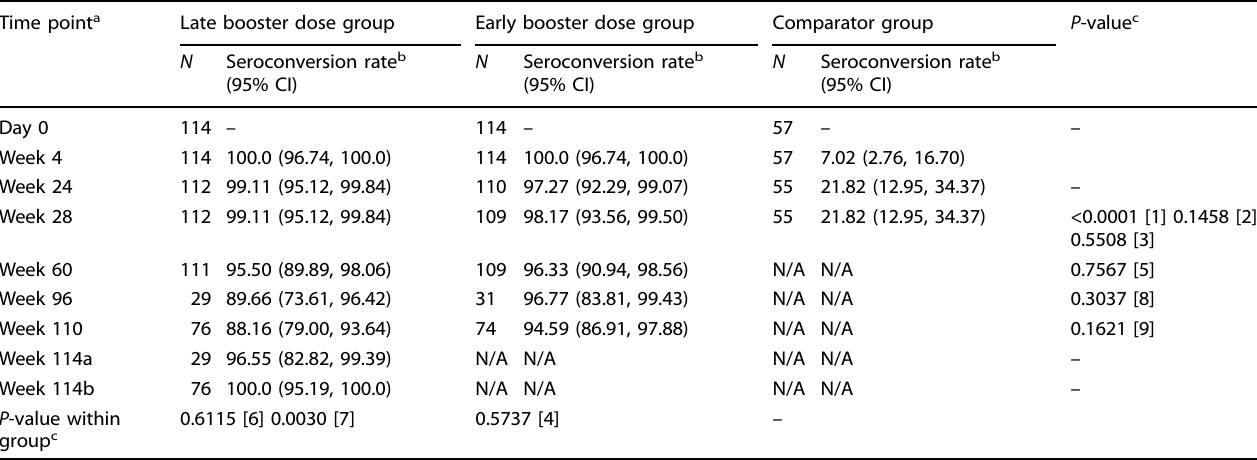
Table 1. Seroconversion of anti-Vi IgG ELISA response — Immunogenicity analysis